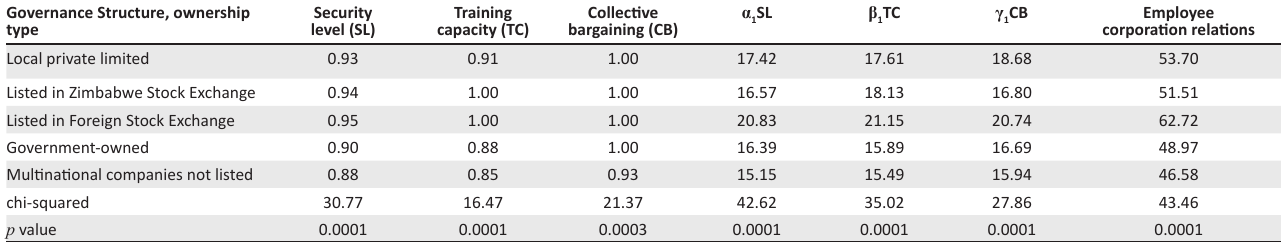
TABLE 3: Employee corporation relations. Governance Structure, ownership